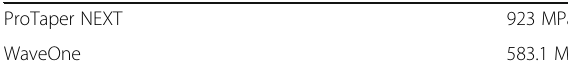
Table 1 The maximum von Mises stress during bending